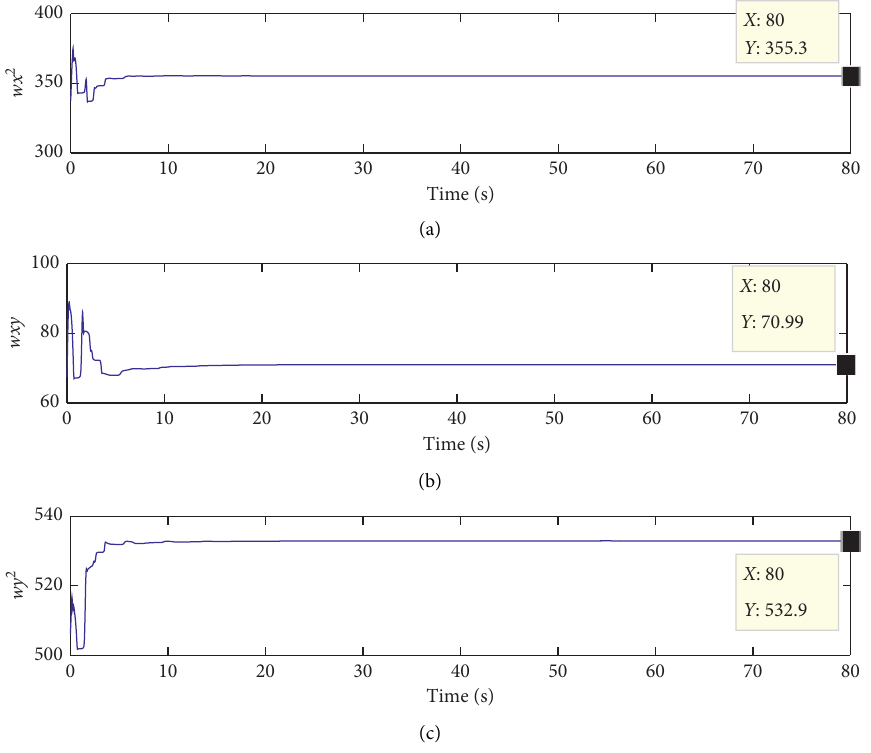
Figure 13: Adaptation of spring constants using fractional fast TSMC.